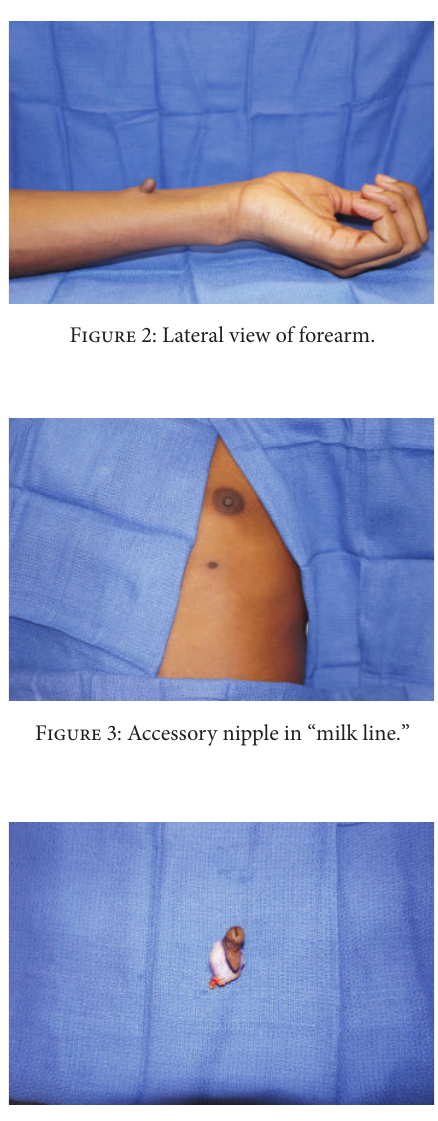
Figure 4: Resected specimen.